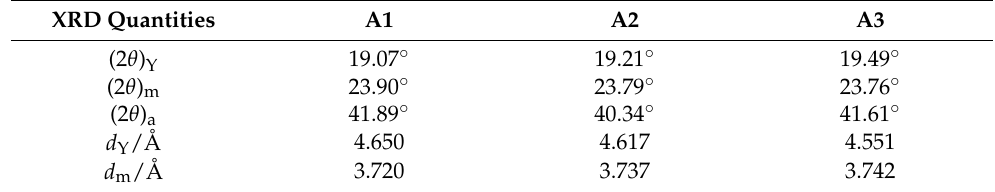
Figure 4. The XRD spectra for the asphaltenes (A1, A2 and A3). The diffraction intensity from position sensitive detector (PSD) is in arbitrary unit (A.U.) and plotted versus diffraction angle 2 θ . The peaks of 002 and 10 band are labelled as m and a respectively. Table 7. The packing length d (in unit of Å) calculated according to diffraction angles (2 θ ) from XRD spectra for the extracted asphaltenes (A1, A2 and A3). Subscripts m and a represent peaks of 002 and 10 band, respectively.